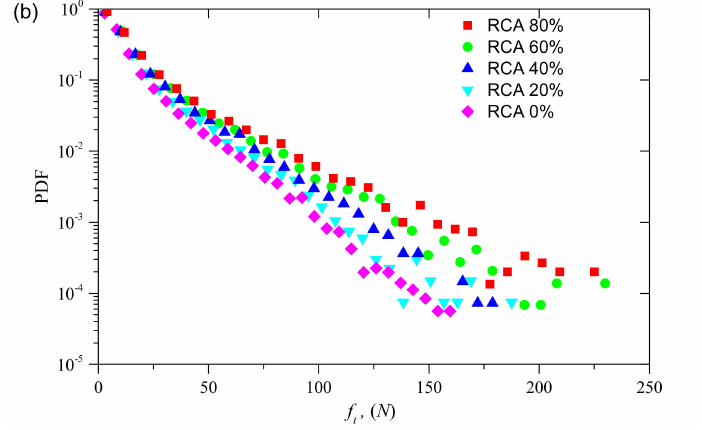
Figure 14. PDFs of samples with different RCA contents: ( a ) normal contact force; and ( b ) shear contact force.